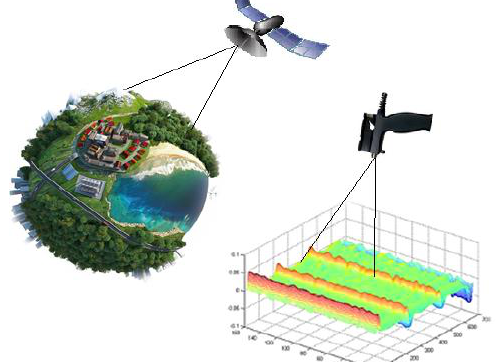
Figure 7: A schematic view of the space-borne data acquisition and its simulation with our laboratory measurement from